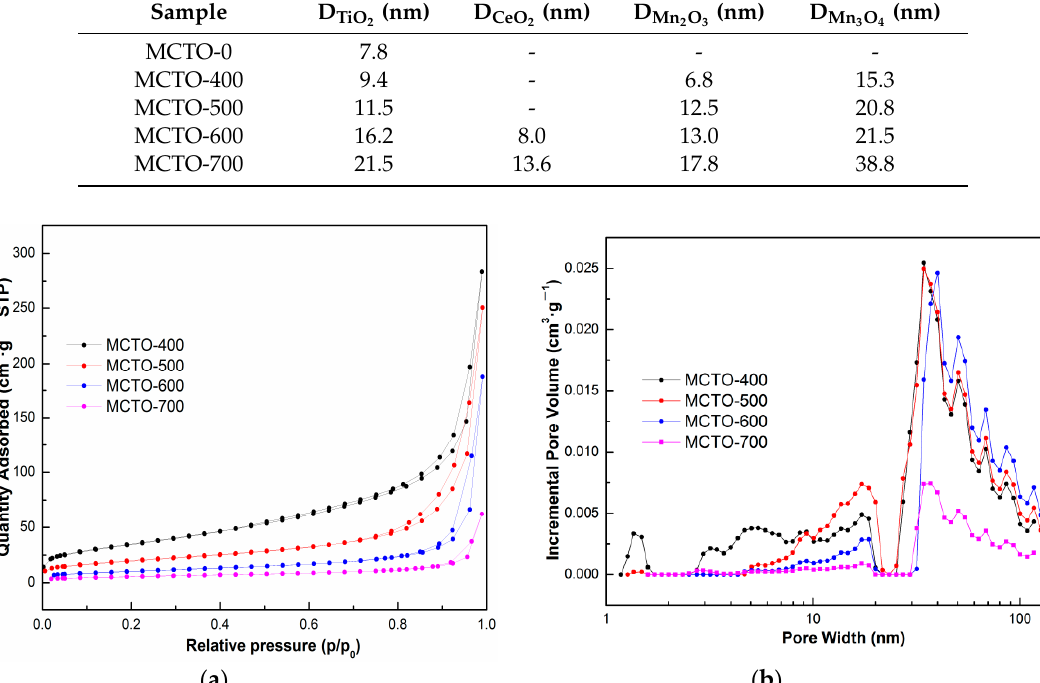
Figure 2. XRD patterns of MCTO-0, MCTO-400, MCTO-500, MCTO-600, and MCTO-700 catalysts. Table 1. The mean crystallite sizes of metal oxides of different catalysts.